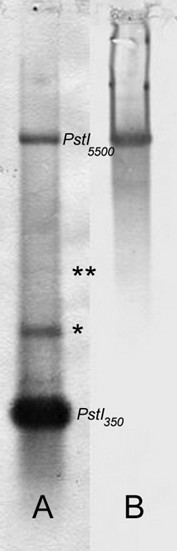
Southern blot. Southern blot of the PstI restriction pattern in B. atticus, using XbaI350 (A) and the PCR-obtained 5'-end of the 18S gene (B) as hybridizing probes. Southern Blot analysis revealed that: i) XbaI350and PstI530 cross-hybridize, with XbaI350being part of the PstI530 fragment (also tested by subsequent sequencing); ii) PstI530 is a tandemly repeated sequence (* = PstI530 dimer; ** = PstI530 trimer), as also supported by XbaI350restriction pattern (not shown); iii) 18S PCR probe and XbaI350 hybridize with PstI5500, so they are associated; iv) the PstI5500 band is the rDNA cluster, since it hybridizes to the 18S probe (also checked by subsequent sequencing).